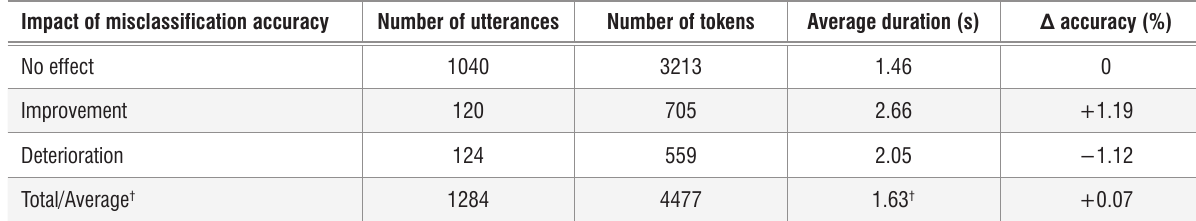
Analysis of accent misclassifications for the parallel per-utterance accent identification system using multi-accent acoustic models Impact of misclassification